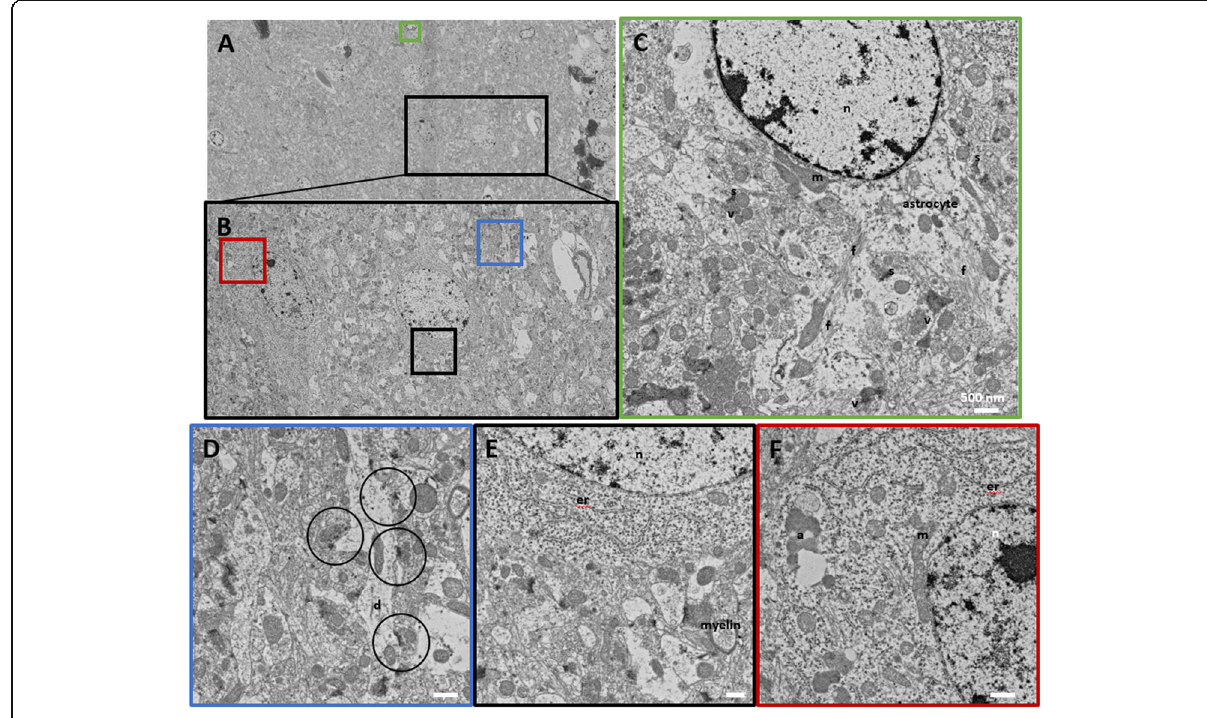
Fig. 3 SEM imaging of a double-stained section. SEM imaging of a double-stained section. a 180 * 80 μ m area, 5 nm/pixel image. b Black box in